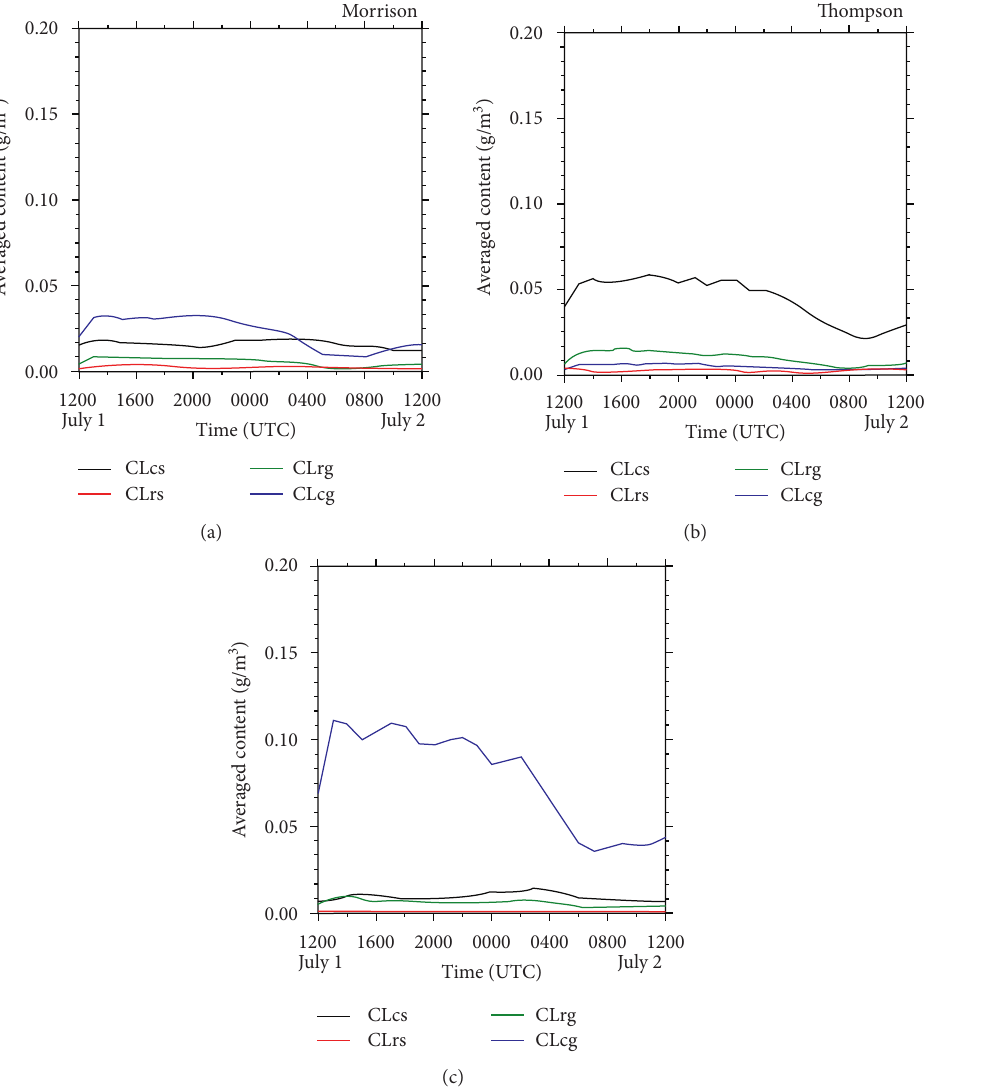
Figure 13: Time series of the mean contents of the riming process in heavy rainfall areas from 1200 UTC on 1 July to 1200 on 2 July 2016: (a) Morrison; (b) Thompson; (c) MY. The black, red, green, and blue lines indicate cloud droplet-snow, raindrop-snow, cloud droplet- graupel, and raindrop-graupel interactions, respectively.